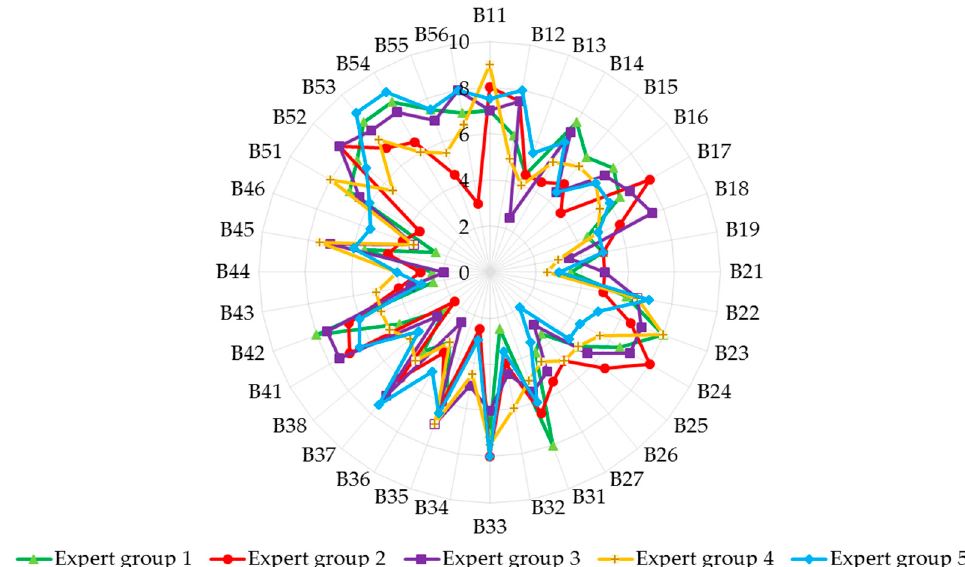
Figure 4. Sub-criteria importance results for the five expert groups.